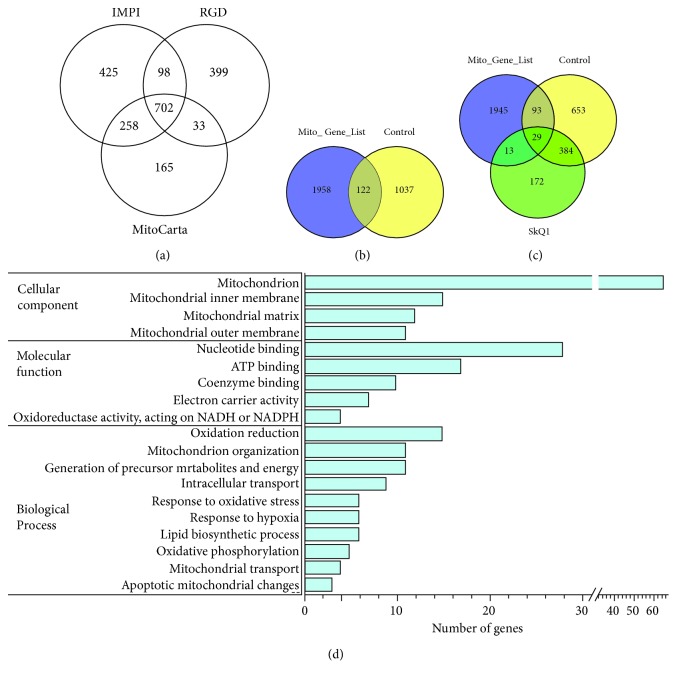
Differential expression of genes related to mitochondrial function in the hippocampus of 18-month-old OXYS rats and the effect of long-term treatment with SkQ1. (a) The Venn diagram shows overlapping sets of genes related to mitochondrial function from MitoCarta 2.0, IMPI Q3 2017, and RGD databases. (b) According to the mitochondrial gene list, the 122 DEGs in OXYS rats are related to mitochondrial function. (c) The Venn diagram suggests that treatment with SkQ1 did not affect the expression of 29 genes in OXYS rats, eliminated differences in the expression of 93 genes, and changed the expression of 13 genes. (d) The number of genes related to mitochondrial function, i.e., associated with GO terms (according to DAVID) that changed expression in control OXYS rats compared to Wistar rats.